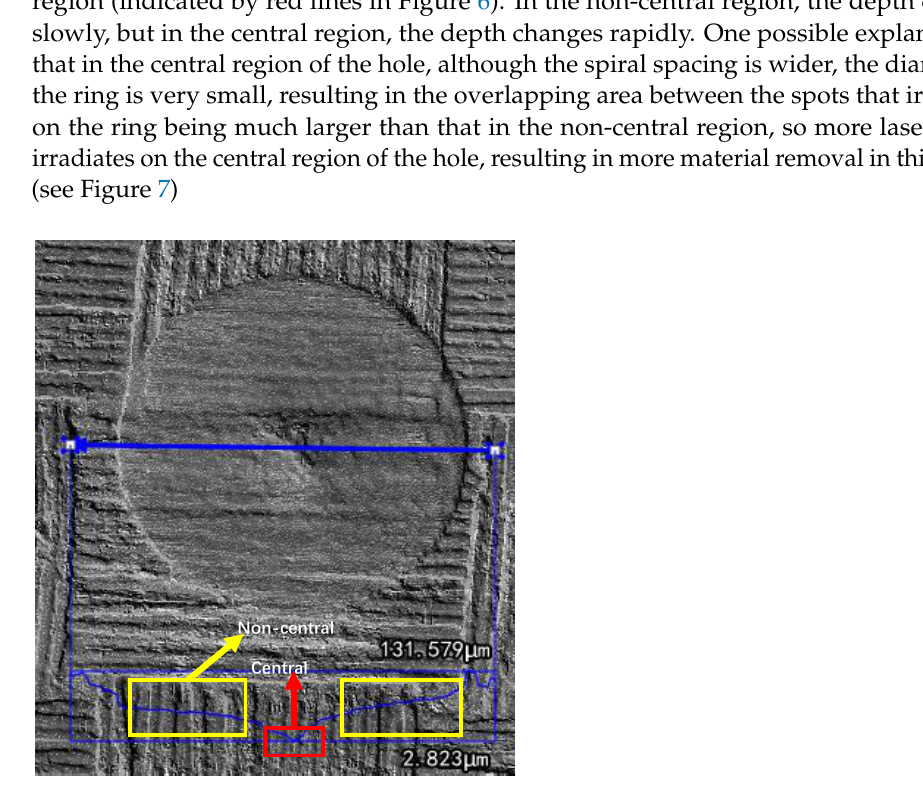
. Figure 7. Depth profile of spiral drilling. Laser power: 0.7 W; number of passes: 25; repetition rate: 50 KHz. In the non-central area along the diameter direction, with the increasing of the diam- eter of the spiral laser drilling trajectories, the distance between the spiral rings decreases, which leads to the increase of the spot overlap rate between the rings, which means more material will be removed. At the same time, because the spiral drilling apparatus rotates at the same angular speed during processing, the spot overlap rate of the ring with larger diameter is smaller than that of the ring with smaller diameter, which means there will be less material removed (see Equation (5), where R is the laser repetition rate, d is ring di- ameter, v is angular speed of laser drilling, and q is spacing of laser spots). R q dv = (5)